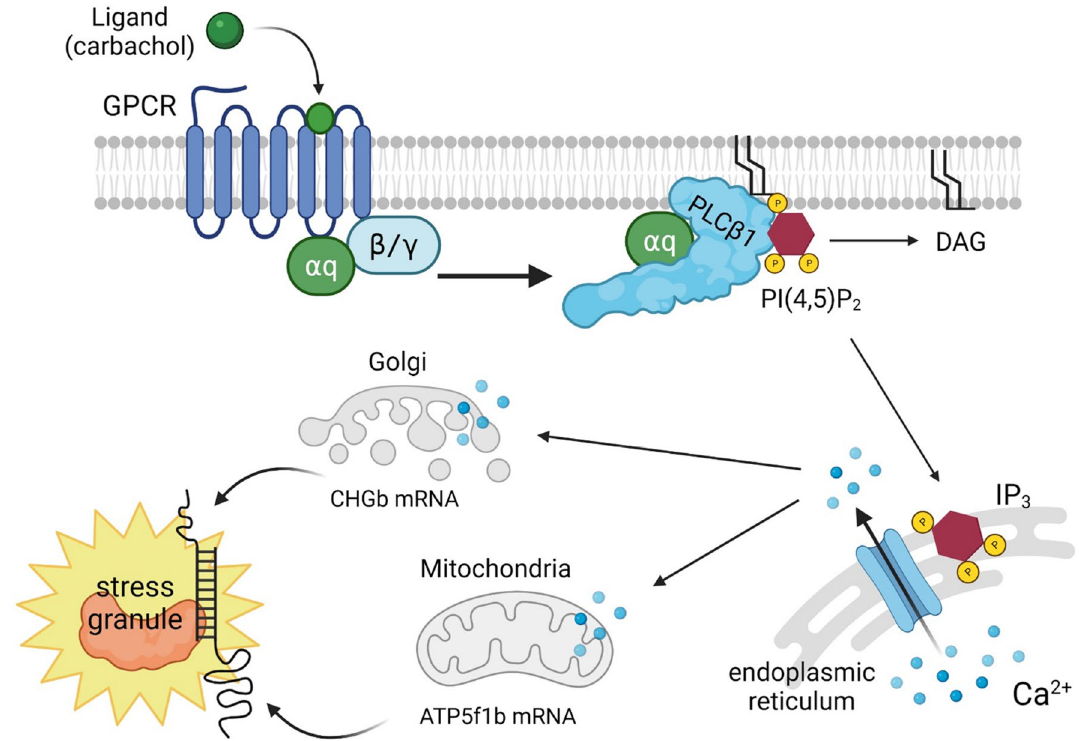
Figure 5. Model connecting the Gαq pathway with specific transcripts sequestered with activation. When PLCβ1 is activated by Gαq, Ca 2+ is released. This excess calcium is believed to flood the mitochondria and Golgi, leading to the movement of Chga/b and ATP5f1b mRNA into stress